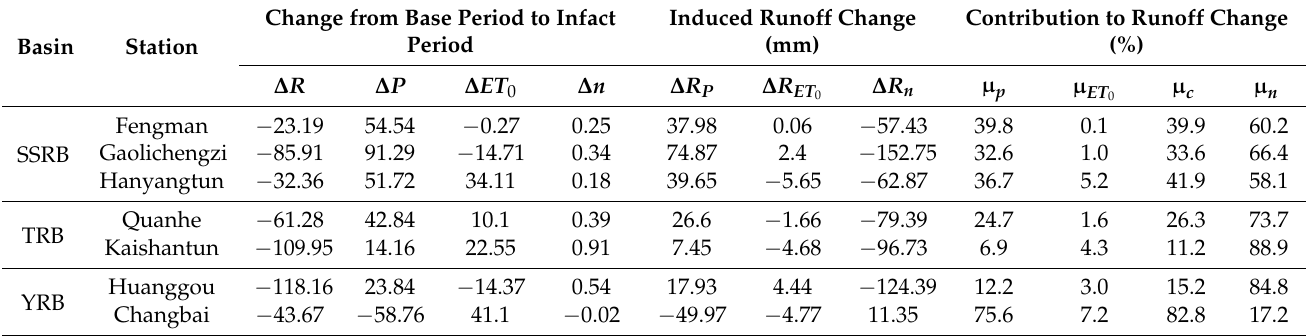
Table 4. Attribution analysis for the Changbai Mountain